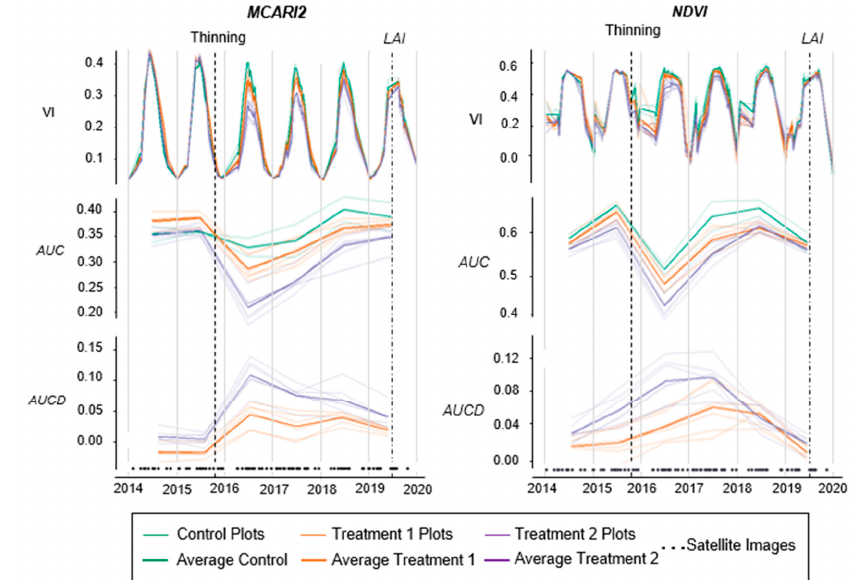
Figure 5. Evolution of the values for MCARI2 and NDVI with all of the valid L8 images available between 2014 and 2019 Trial 1. Areas under the annual VI curves ( AUC ) and differences in AUC between control and treatment plots ( AUCD ) for the same time series. Thinning refers to when the treatments were conducted and LAI refers to when fieldwork was carried out. Remote Sens. 2020 , 12 , x FOR PEER REVIEW